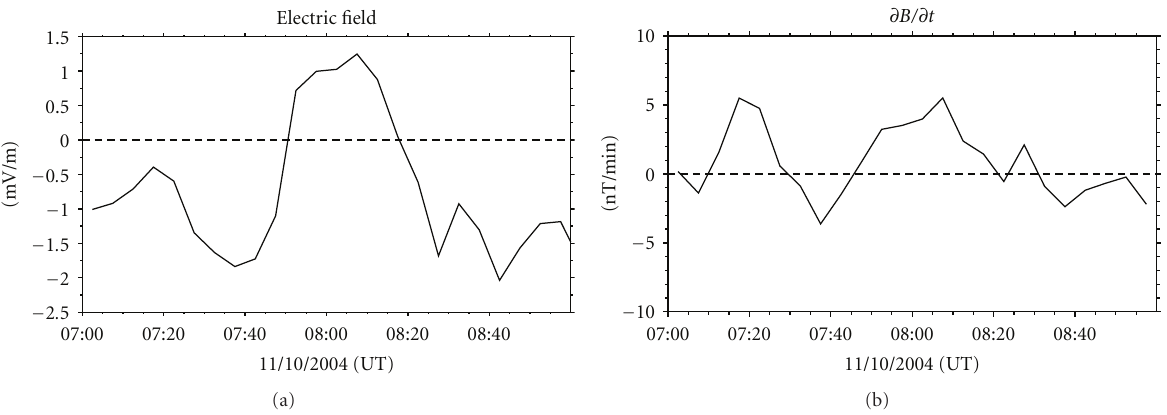
Figure 4: Comparison of the time-derivative of the horizontal component of the magnetic field simultaneously with the eastward electric field. Both quantities were measured at Jicamarca,